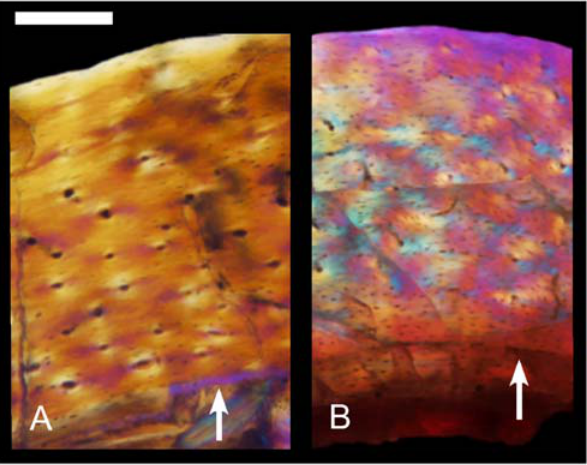
Figure 8. Femoral histology of the basal birds Jeholornis and Sapeornis viewed with polarized microscopy. (A) In Jeholornis (IVPP 13353), parallel-fibered bone matrix similar to that of Archaeop- teryx makes up the cortex. However porosity is greater as in Mahakala . A growth line that locally varies between a line of arrested growth and an annulus is shown (arrow). (B) In the larger Sapeornis (LPM B00166), the matrix is primarily woven-fibered and shows a mix of longitudinal and reticular vascularization. Avascular parallel-fibered bone brackets a line of arrested growth (arrow) in this sub-adult specimen. Scale bar =0.15 mm